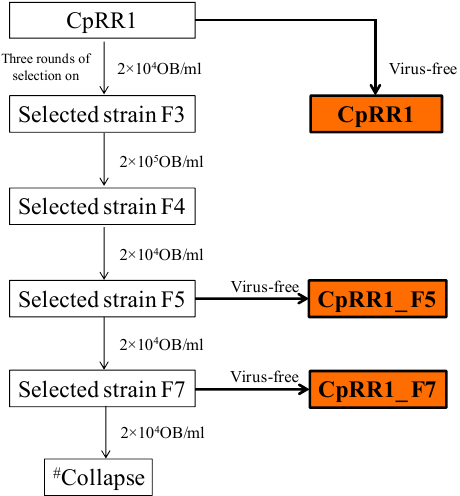
Figure 1. Selection process to regain a high level of resistance of CpRR1. # Collapse of colony since only a very few male or only female adults survived during selection on CpGV-M.